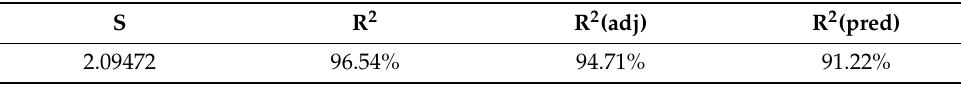
Table 5. Model summary of CL selectivity.